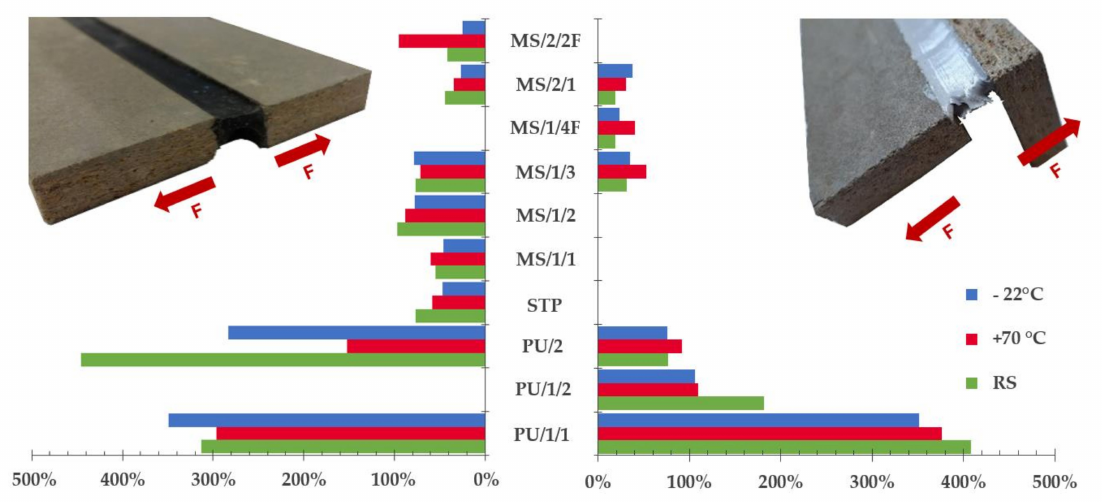
Figure 4. Comparison of the tensibility of test samples subjected to artificial weathering methods with the reference set: design A ( left ) and design B ( right